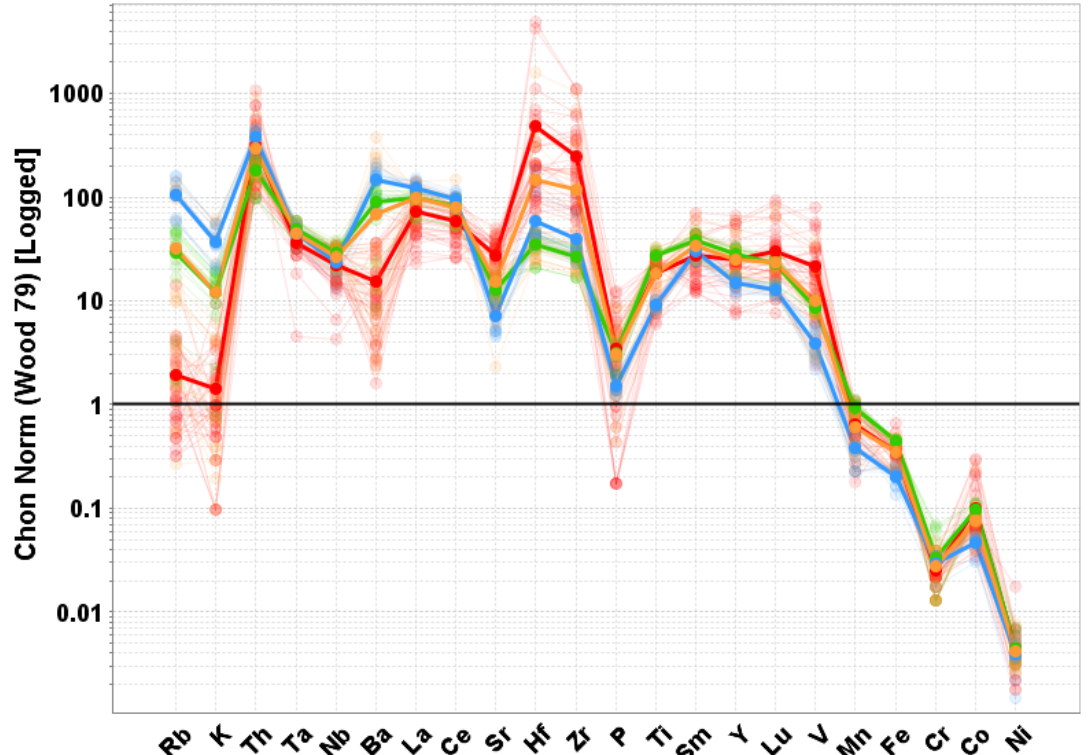
Figure 6. Chondrite-normalised spidergram of selected elements in Valhalla albitites (plotted using the method of [27]). Solid lines represent average compositions for the four rocktypes in Table 2. Red, albitite; orange, chlorite and riebeckite schist; green, metabasalt; blue,